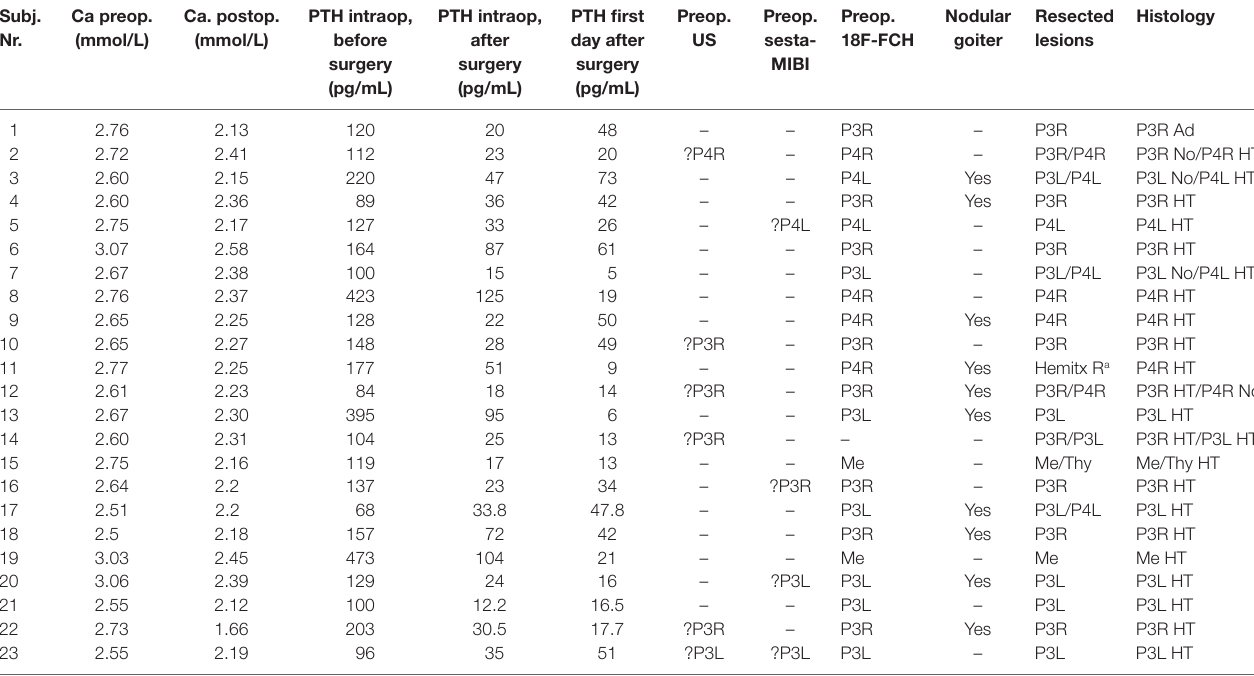
TaBle 2 | Laboratory findings, imaging, and histological results. subj. nr.